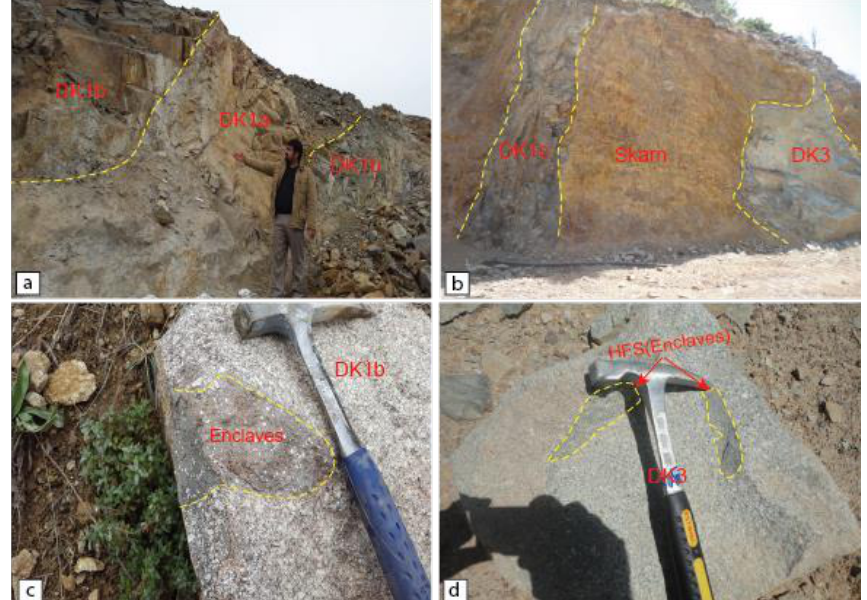
Figure 4. ( a ) Dykes trend in Sungun copper deposit (N = 752); ( b ) Dip of dykes in Sungun copper deposit. Minerals 2018 , 8 , x FOR PEER REVIEW